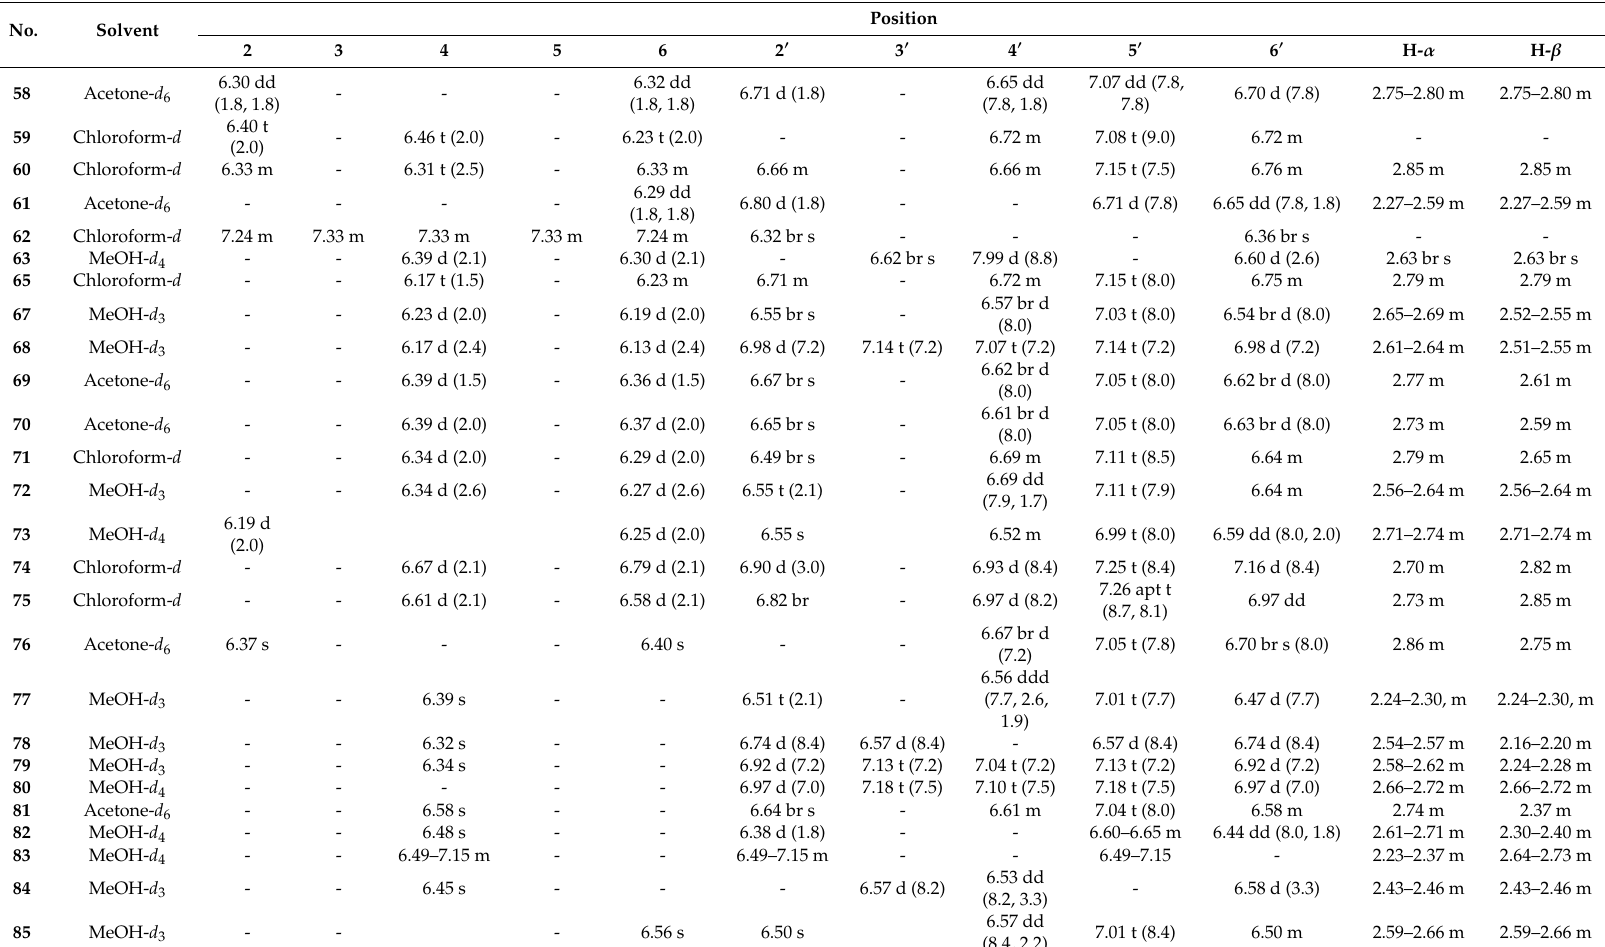
Table 6. 1 H NMR data of compounds 58 – 101